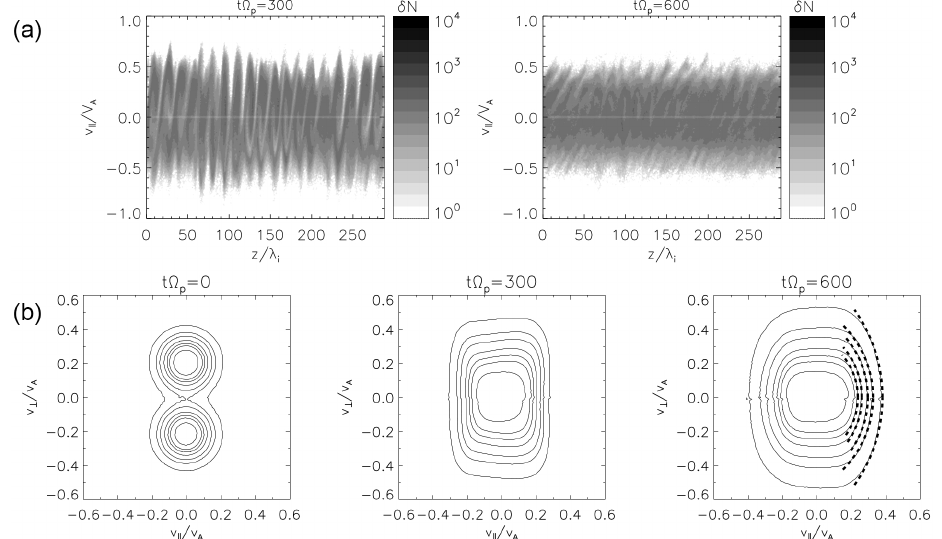
Figure 3. (a) Proton phase space z − v (cid:107) at time t(cid:127) p = 300 close to the linear saturation of the decay instability and at the final time t(cid:127) p = 600 of the simulation. The particle density is represented in a gray-coded scale with a minimum defined by the lightest nuance of gray. (b) Proton-reduced distribution functions represented as contour levels (solid line) determined in the plane ( v (cid:107) ,v ⊥ ) at times t(cid:127) p = 0, t(cid:127) p = 300, and t(cid:127) p = 600. The segments of circles represented by dashed lines describe diffusion plateaus (see text).